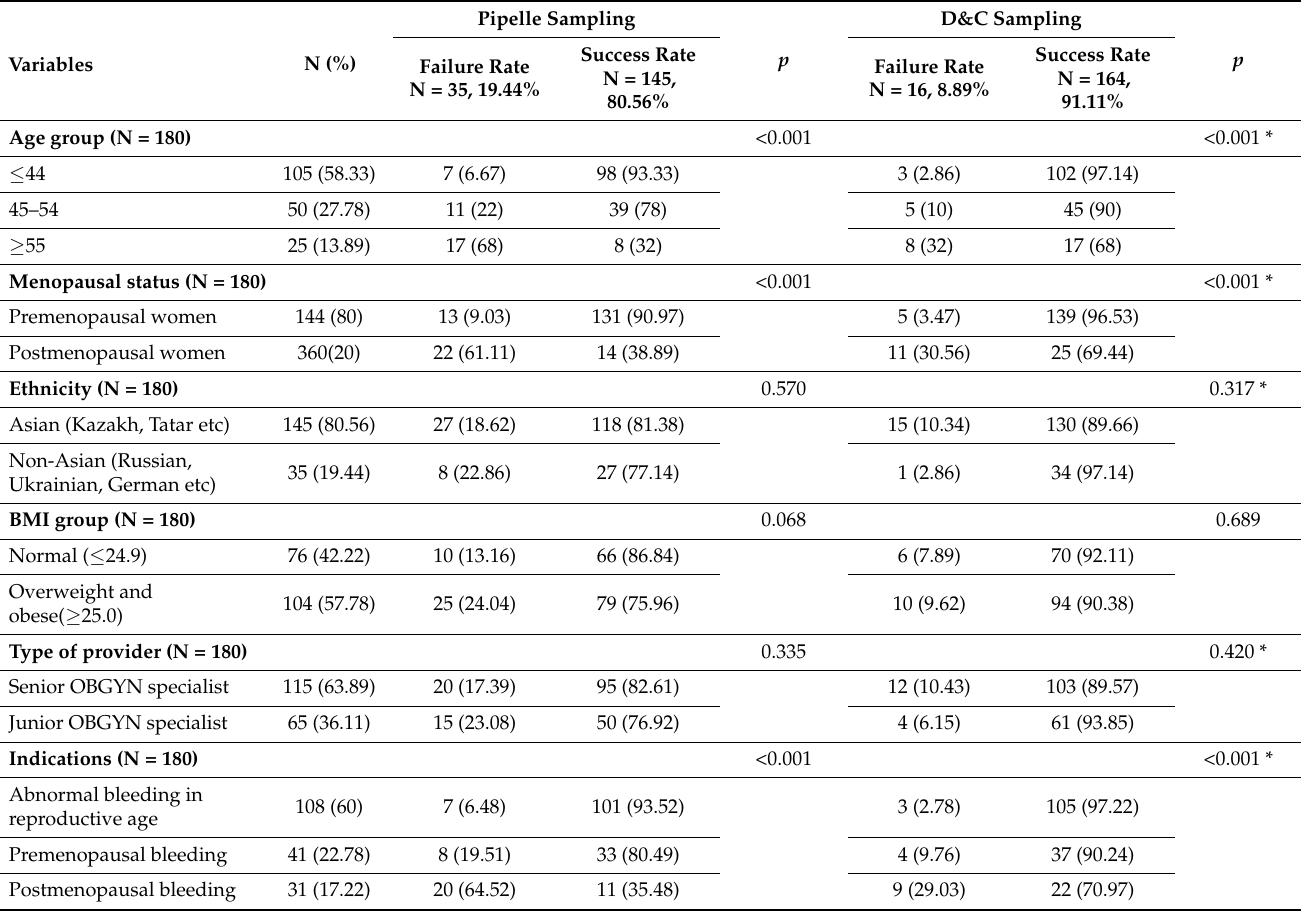
Table 1. Pipelle endometrial sampling failure rate: impact of age, BMI, ethnicity, indication, and provider type *.